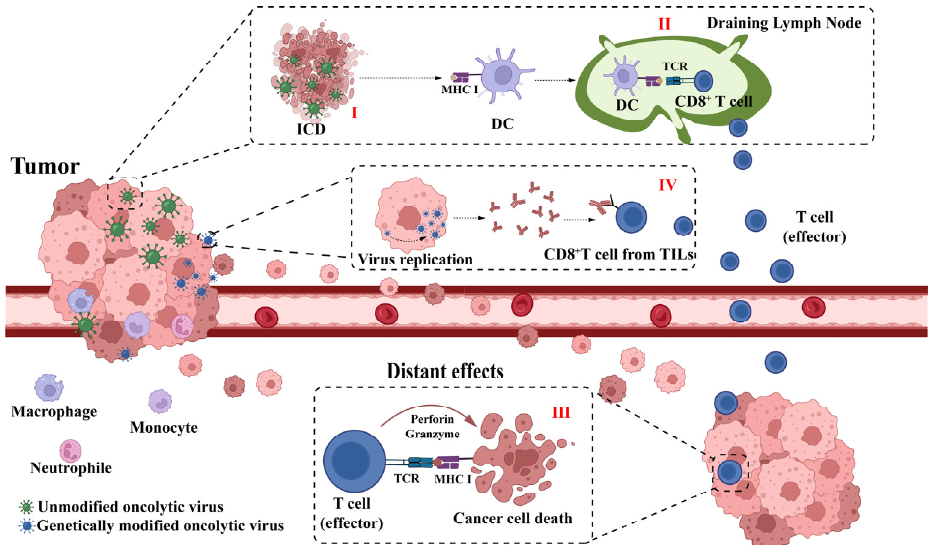
Figure 1. Mechanism of action of oncolytic virus therapy. I: Oncolytic virus (OV) can directly lyse tumor cells and induce immunogenic death of tumor cells, thus, releasing tumor antigens. II and III: Tumor antigens are presented by activated antigen-presenting cells (APCs), which can activate CD8 + T cells in the draining lymph nodes, thus, inducing an organism-specific anti-tumor immune response and playing a role in killing distant metastases. IV: Genetically modified OV promotes antitumor immunity. Genetically engineered OV carrying exogenous genes can improve the immunosuppressed tumor microenvironment (TME) by simultaneously expressing exogenous genes during replication, relieving T-cell suppression, and promoting T-cell activation.